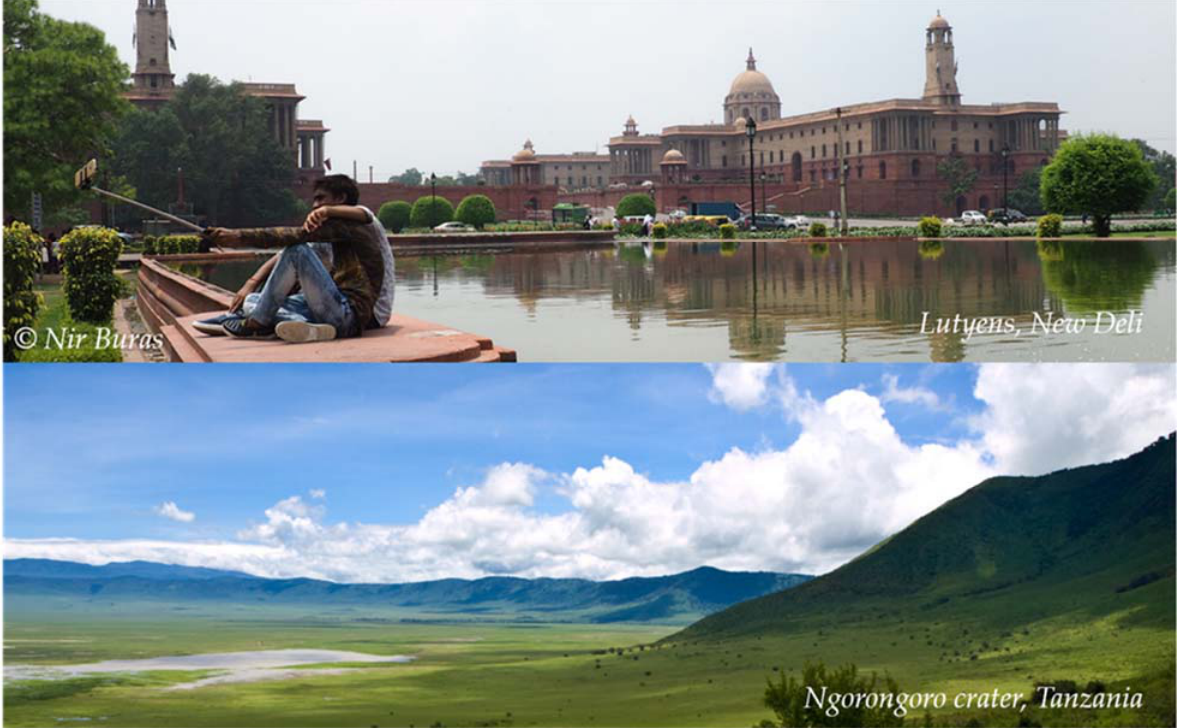
Figure 3. Lutyens’s New Delhi (Top) and the African Savannah (Bottom) share fractal qualities, as opposed to the non-fractal plainness found in more modern buildings. Photos: New Delhi, Nir Buras; Ngorongoro Crater, William Warby, CC BY 2.0 Wikimedia Commons, https://commons.wikimedia.org/wiki/File:Ngorongoro_Crater.jpg (accessed on 30 December 2021).